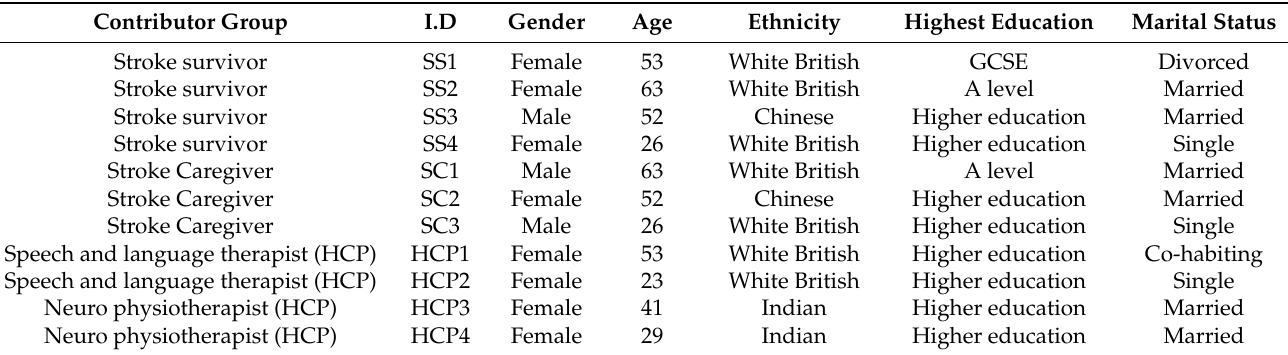
Table 1. PPI collaborators’